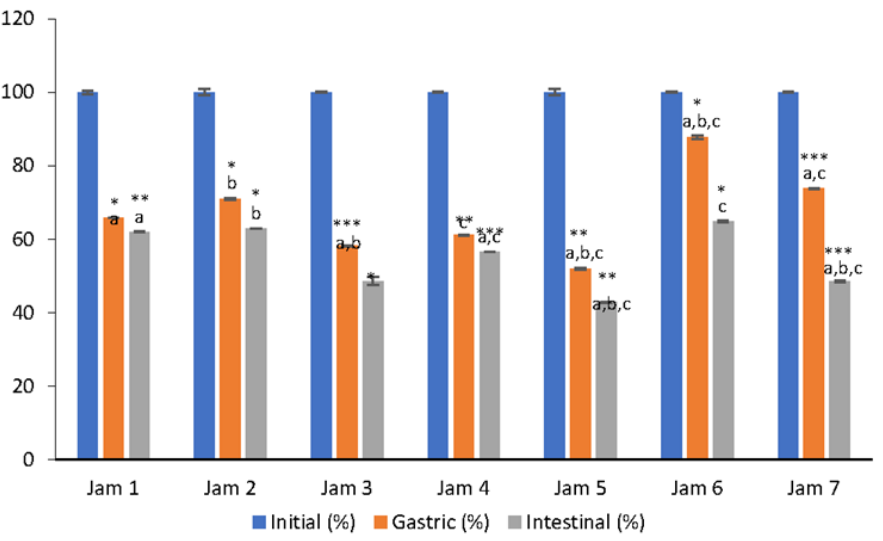
Figure 1. Changes in bioaccessibility (%) of vitamin C during in vitro simulated digestion of lingonberry jams. Data represent average values ± standard deviation of three independent measurements and initial bioaccessibility determined in non-digested jams is set as 100%. Letters a,b,c indicate statistically significant differences between the values for each phase of digestion ( p < 0.05) according to Student’s t tests. Asterisk symbols signify the following levels of statistical significance of differences according to one way ANOVA and Student’s t tests: *** p < 0.0001, ** p < 0.001, * p < 0.05.